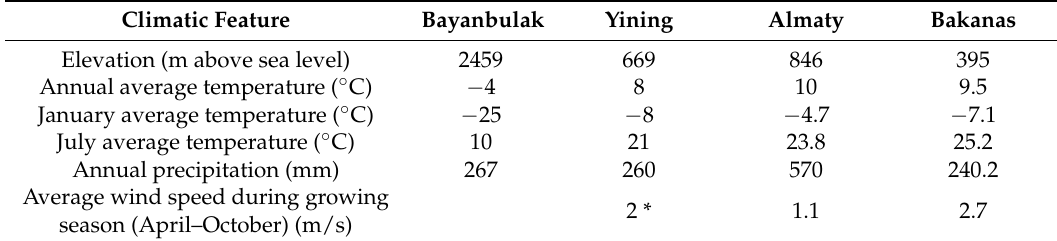
Table 1. Climatic features of Bayanbulak, Yining City, Almaty, and Bakanas (www.weatherbase.com). Climatic Feature